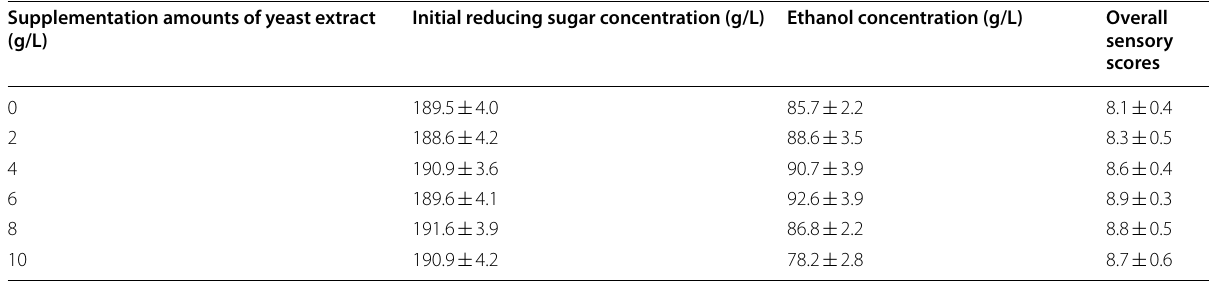
Table 6 Effect of different supplementation amounts of nitrogen nutrient on production of Chinese chestnut wine after 6 days of co-culture fermentation Supplementation amounts of yeast extract